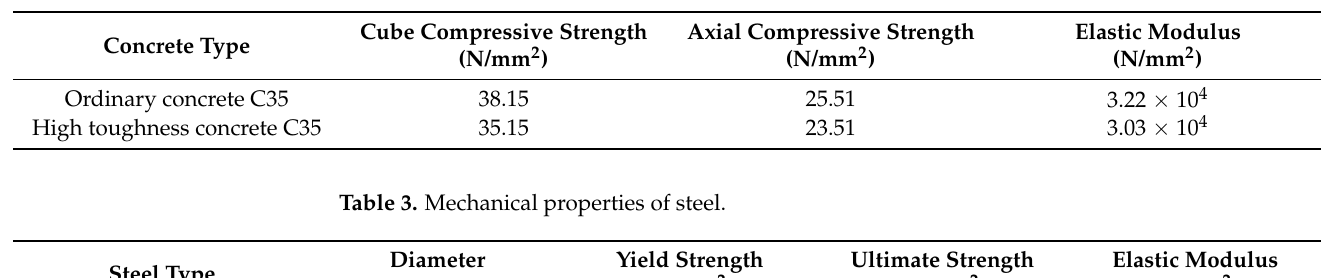
Table 2. Mechanical properties of concrete.